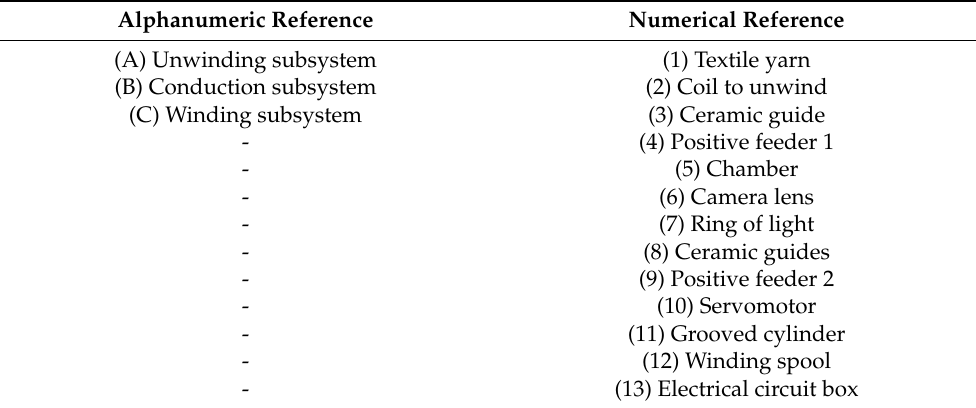
Figure 27. Mechatronic system developed (description presented in Table 2). Table 2. Nomenclature of mechanical system components [35].